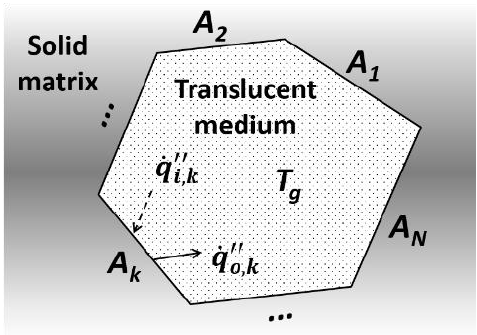
Figure 9. Unit enclosure, which is composed of N discrete elemental surfaces and filled with translucent media.